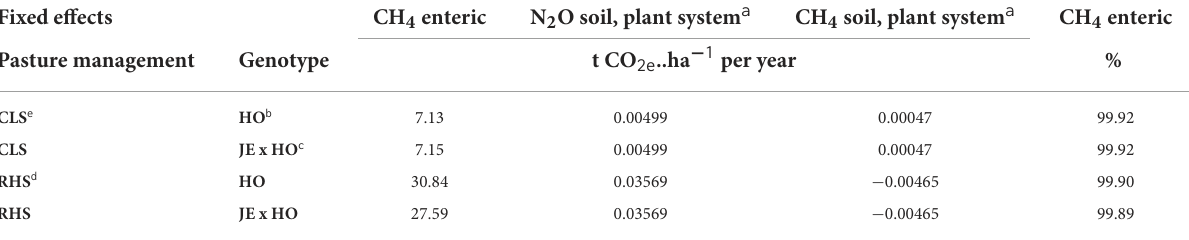
TABLE 3.1 Contribution of enteric CH 4 and GHGs from the soil–plant system in the composition of GHG emissions for the interaction of two levels of intensification in grazing management systems and two cow genotypes.